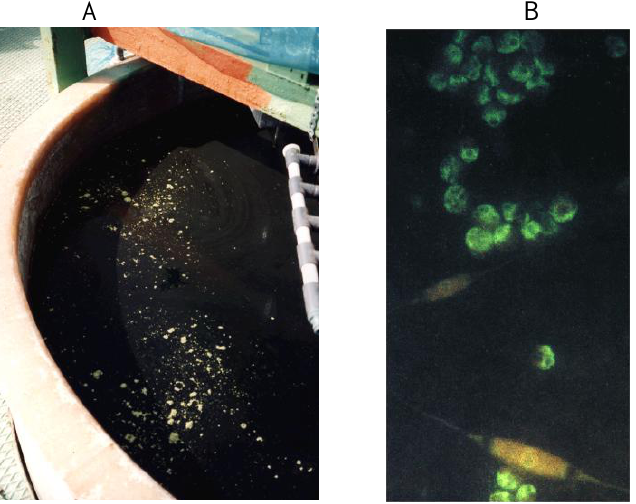
Figure 1. Sample from a biofilm on a mesocosm tank (a) during the EU AIMS